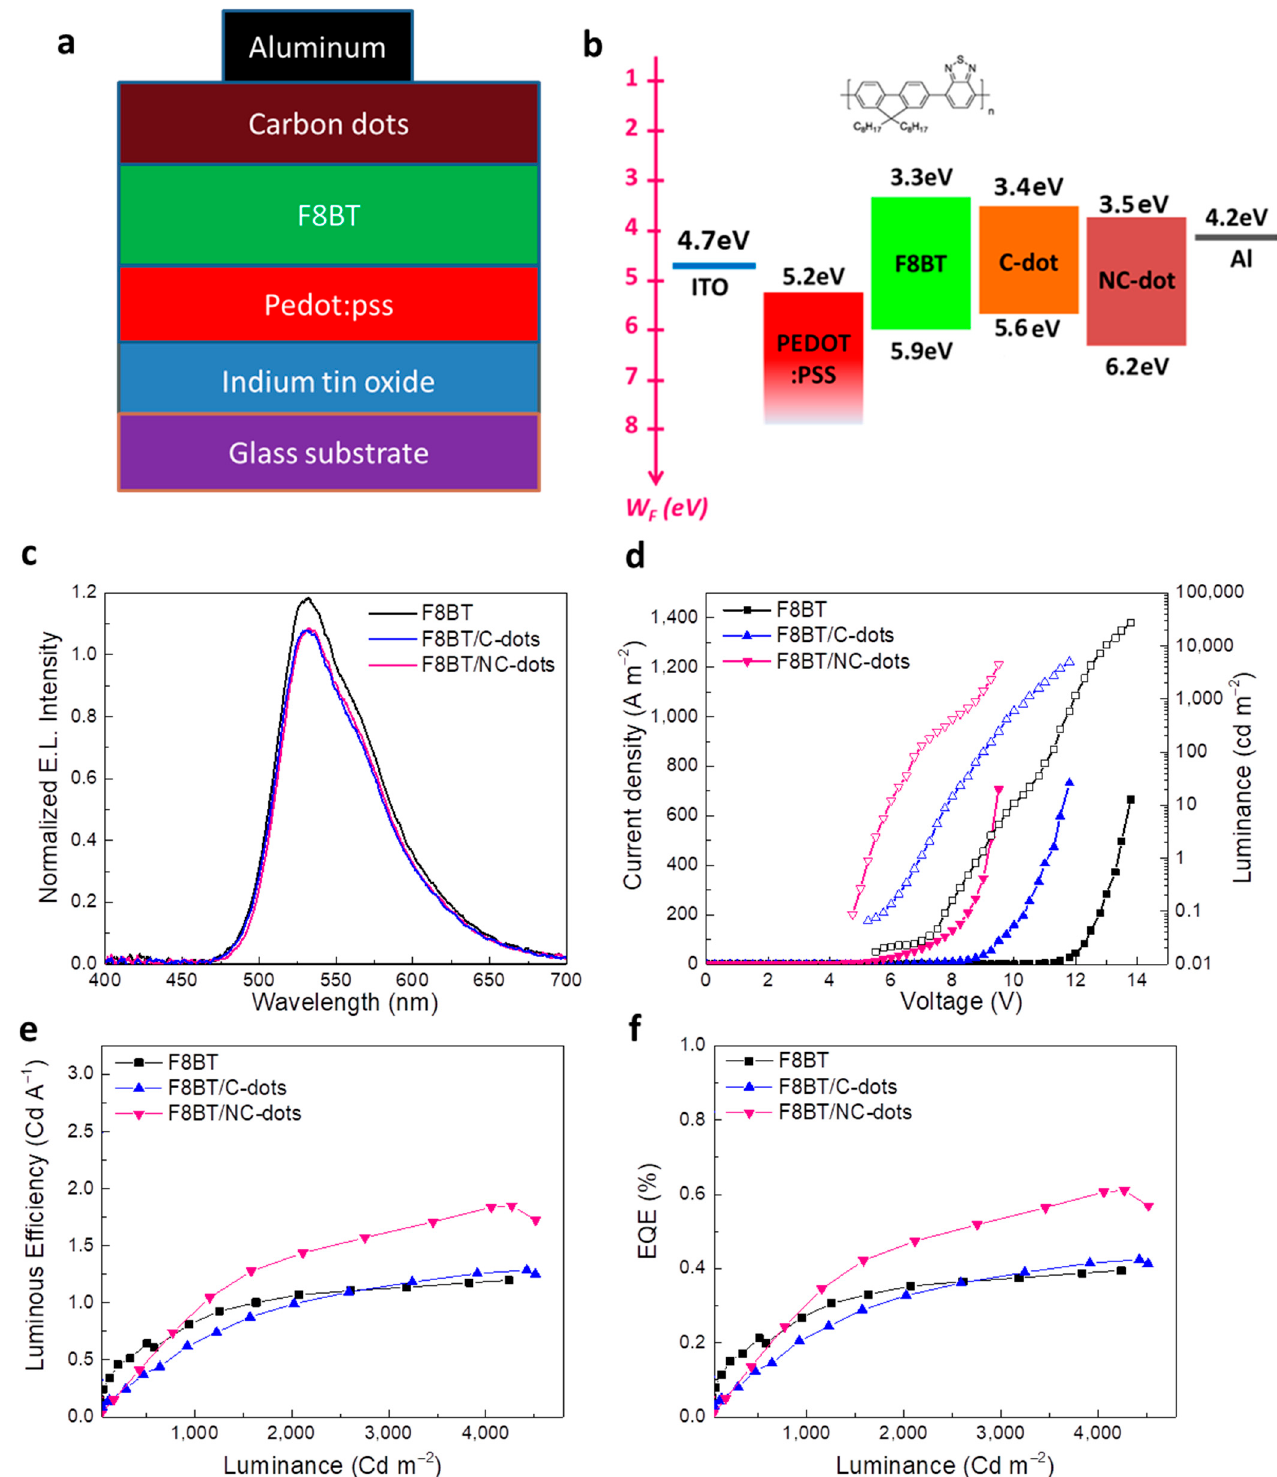
Figure 6. ( a ) The OLED architecture and ( b ) the corresponding energy level diagram. The chemical structure of the F8BT is also presented. ( c ) Electroluminescence (EL) spectra of the different devices at a voltage of 5 V. ( d ) Current density (solid symbols)–voltage and luminance (open symbols)–voltage characteristics of the three types of OLEDs. ( e ) Luminous efficiency (LE) and ( f ) external quantum efficiency (EQE) of the same devices.